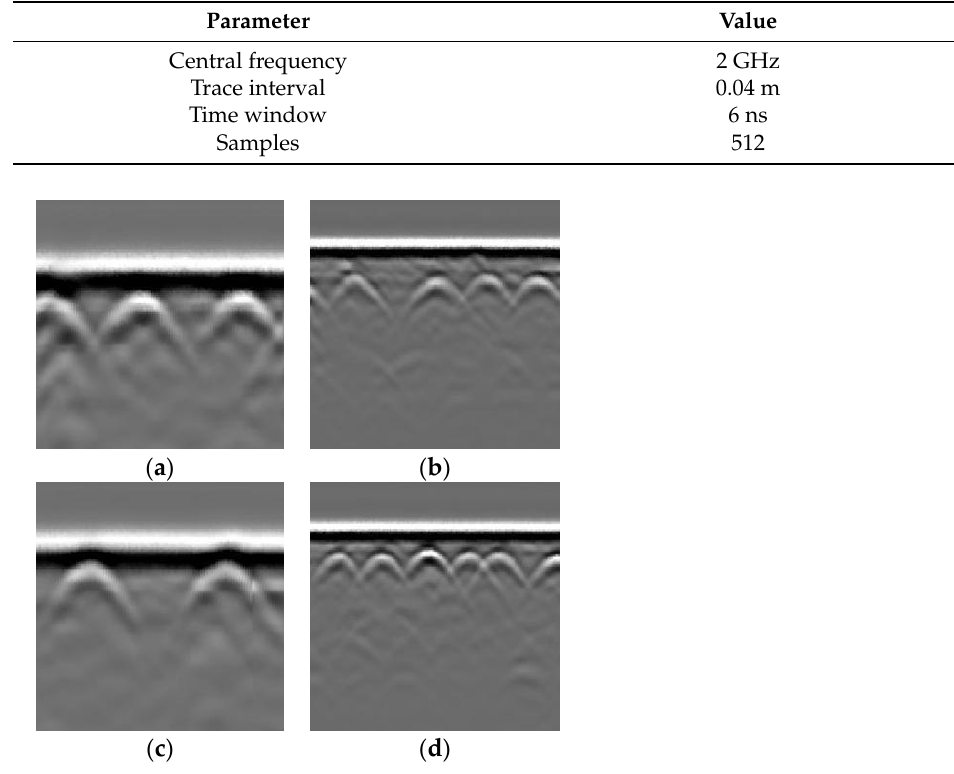
Figure 3. ( a ) The system used for GPR images acquisition and ( b ) GPR images of the field data collection [17]. Table 3. Parameters for GPR data acquisition.